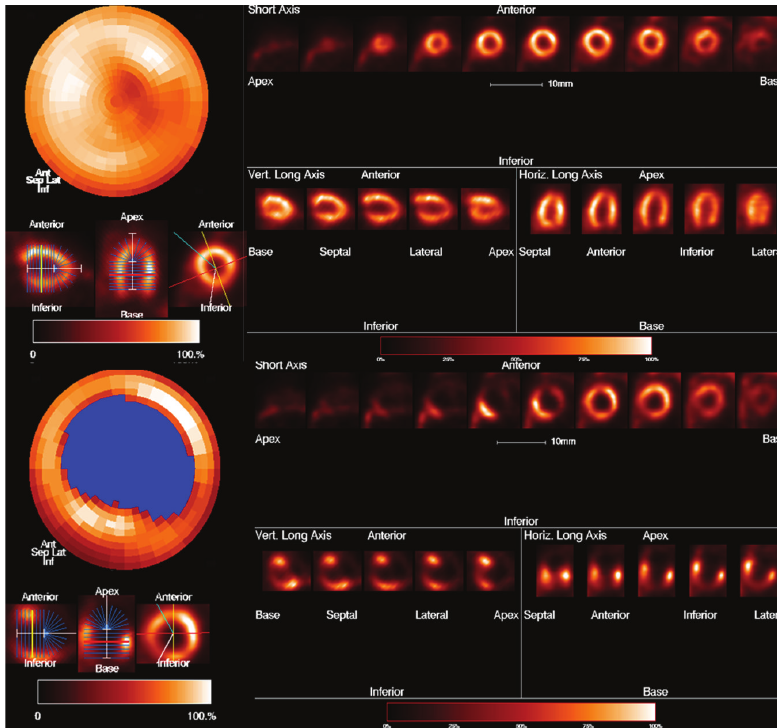
Figure 4: [ 18 F] FDG PET. Left ventricular polar map obtained in a normal mouse (top) and in a mouse with myocardial infarction (lower) by MunichHeart